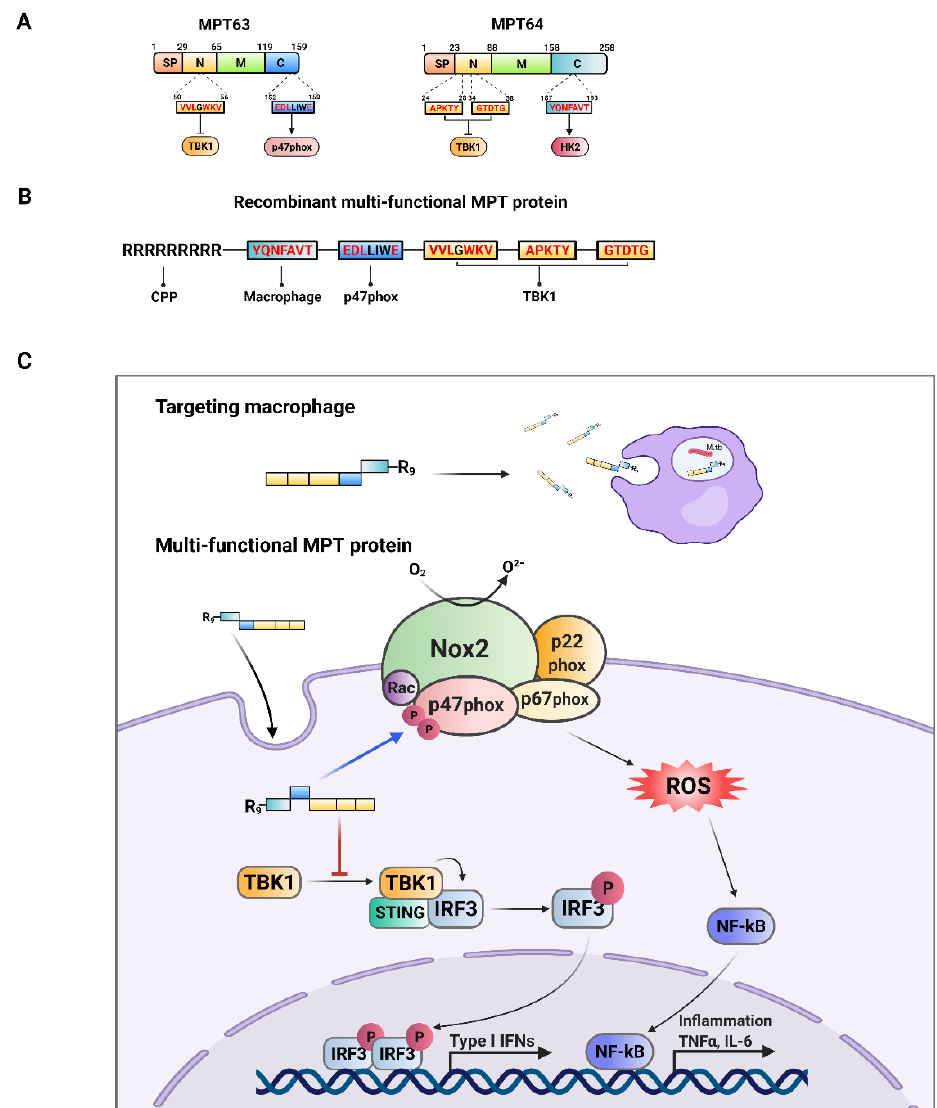
Figure 9. Schematic model for the roles in rMPT against MTB infection. ( A ) Domain screening of interacting site between MPT63 or MPT64 with TBK1, p47phox and HK2. ( B ) Construction of rMPT combined TBK1, p47phox, and HK2 interacting domains in MPT63 and MPT64. ( C ) Regulatory pathway of rMPT in macrophages.